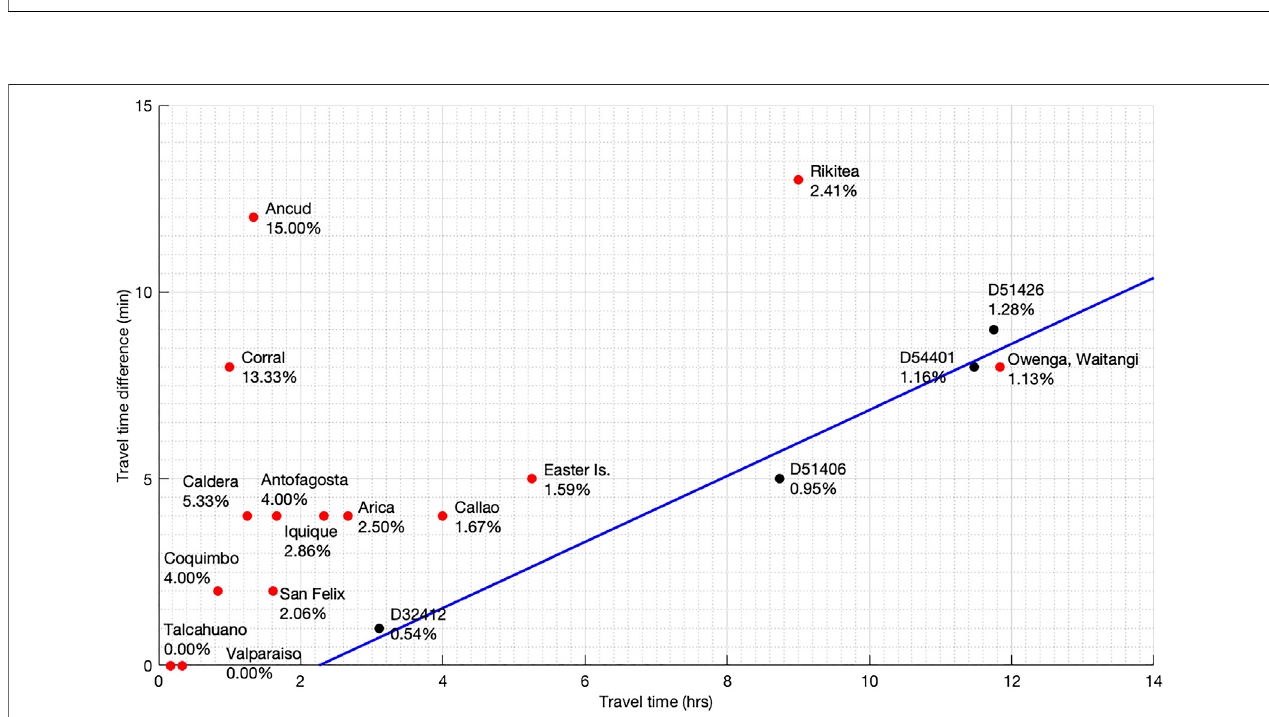
FIGURE10| Time-shift(absoluteandpercentage)estimatedforDARTbuoys(blackdots)andtide-gauges(reddots)usingtheOTAmethodintheinversionshown in Figure 6 plotted vs. the observed arrival time. The blue line shows a systematic trend with distance for the DART data.